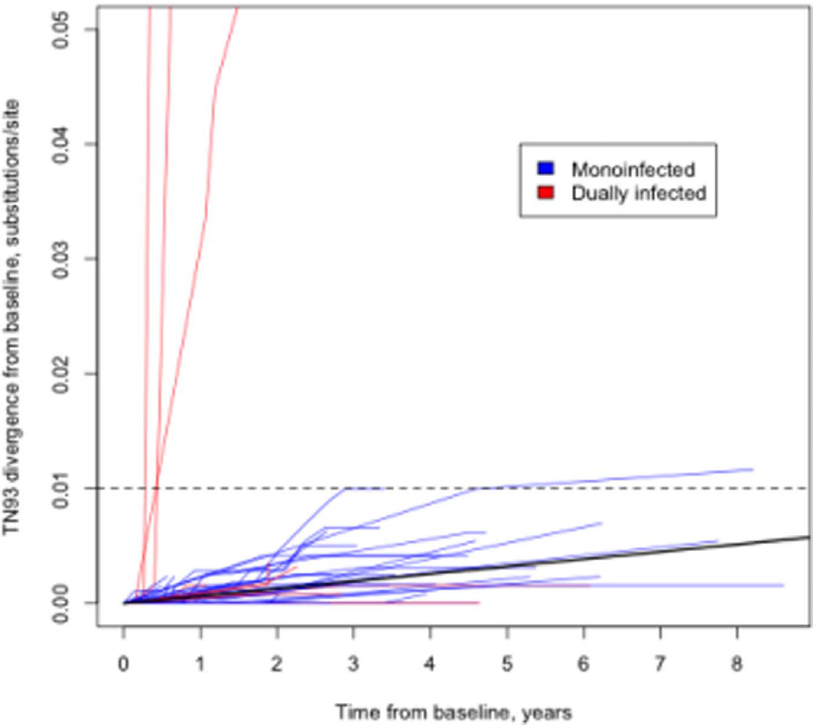
Figure 1. Divergence from baseline, based on the phylogenetic estimates under the TN93 model without assuming a molecular clock for each of the 93 study participants. The solid line represents the mean evolutionary trajectory inferred from mono-infected samples. The dashed horizontal line depicts the 1% genetic distance cutoff, used previously to infer potential epidemiological linkage [11–13].